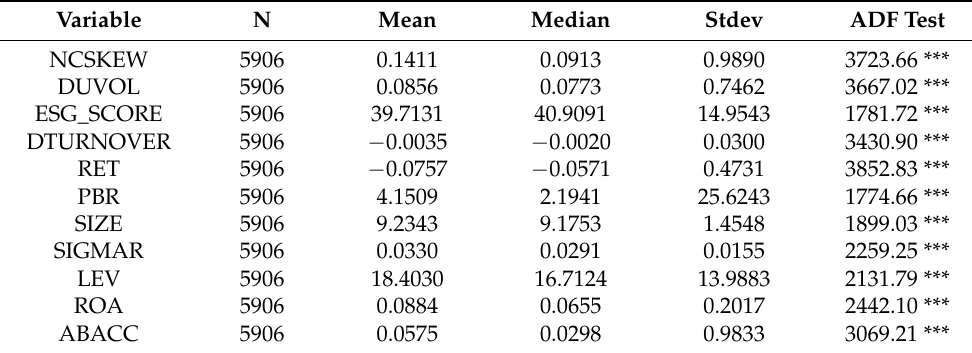
Table 2. Descriptive statistics for Euro STOXX 600